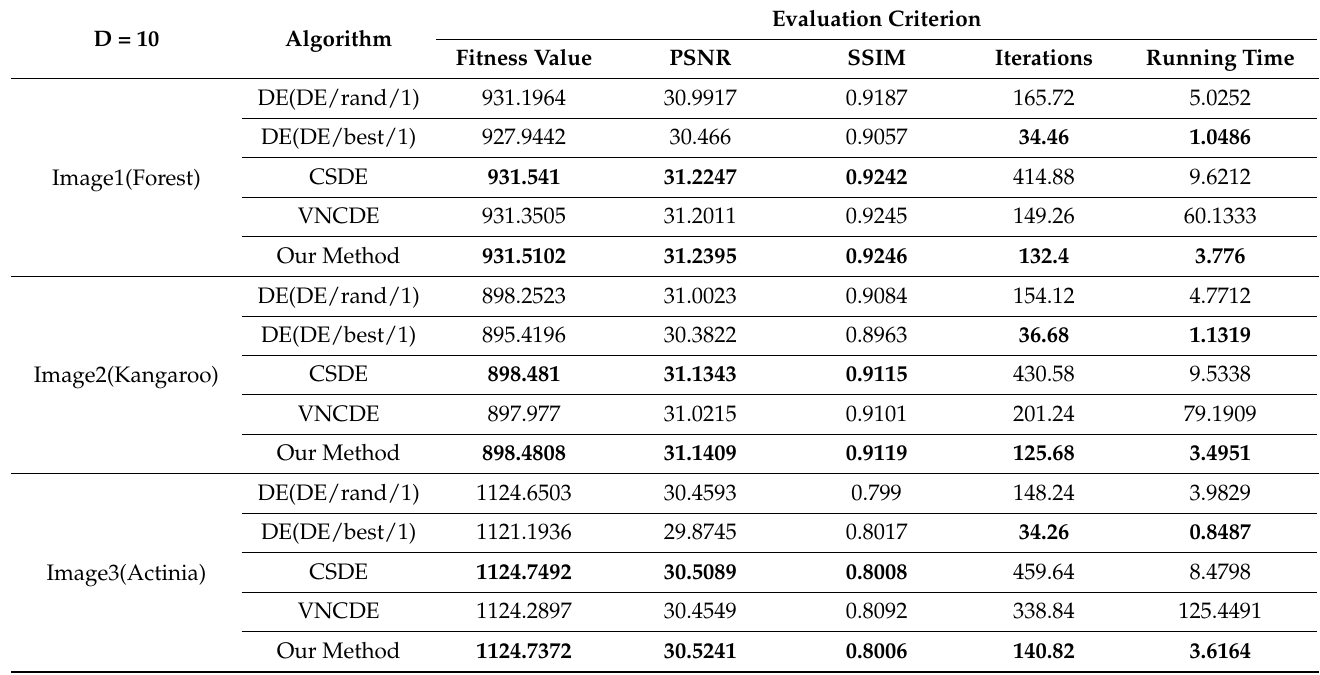
Table 3. Results comparison of five algorithms for segmentation of images 1–3 on different criteria when D =